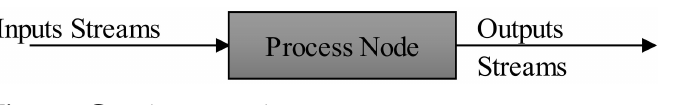
Figure 3. Generic process view. Table 1. Typical failure modes of general process